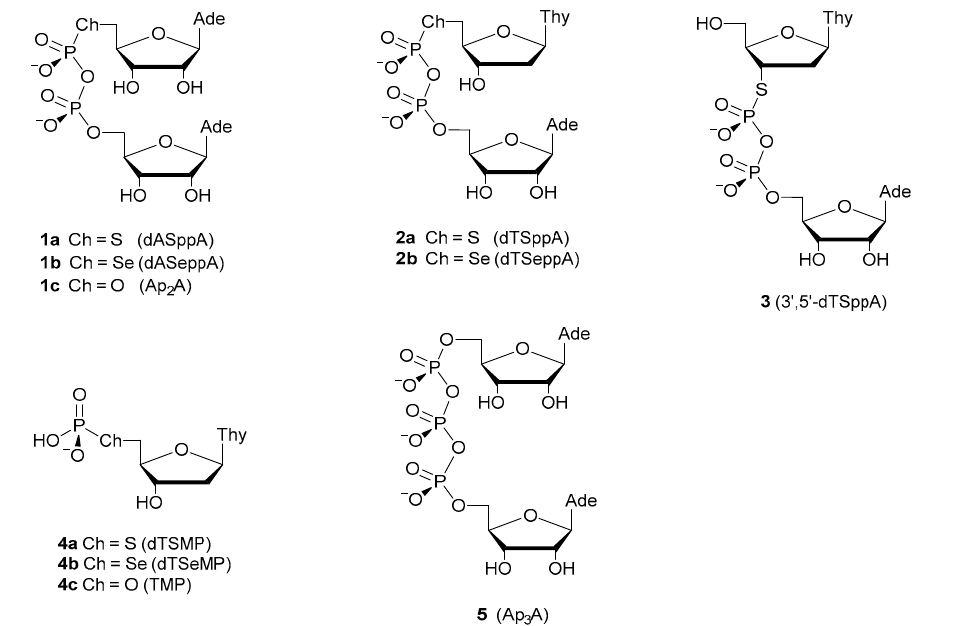
Figure 2. Structures of chalcogen-substituted nucleotide analogues and the natural pyrophosphate- linked dimers, Ap 2 A and Ap 3 A. Key. Ade: N 9 -adeninyl. Thy: N 1 -thyminyl.